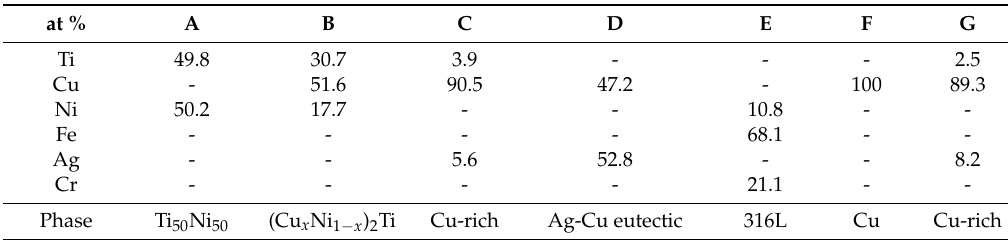
Figure 3. SEM (scanning electron microscope) backscattered electron images (BEIs) of Ti 50 Ni 50 /Cusil-ABA/70 μ m Cu foil/BAg-8/316L SS specimen infrared brazed at 820 °C for 300 s: ( a ) the cross-section; ( b ) the Ti 50 Ni 50 substrate side; ( c ) the 316L SS substrate side. Table 2. EDS chemical analysis results in Figure 3.